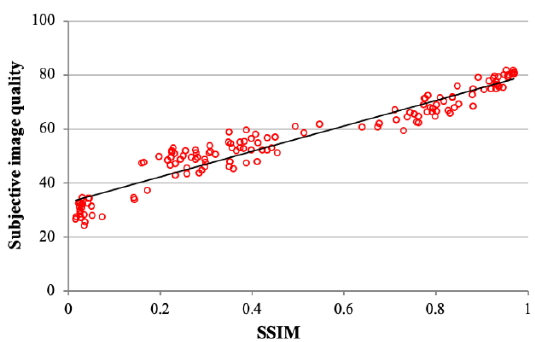
Figure 7. Relationship between the perceived image quality and structure similarity (SSIM) values.